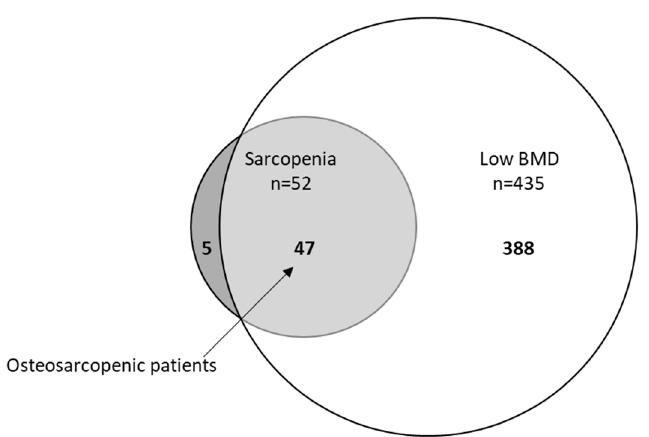
Figure 2. Venn diagram displaying extent of overlap between sarcopenia and low BMD (bone mineral density) in total population (n = 572). Small circle: sarcopenia (52/572, 9%), big circle: low BMD (435/572, 76%), light grey osteosarcopenia patients (47/572, 8%).